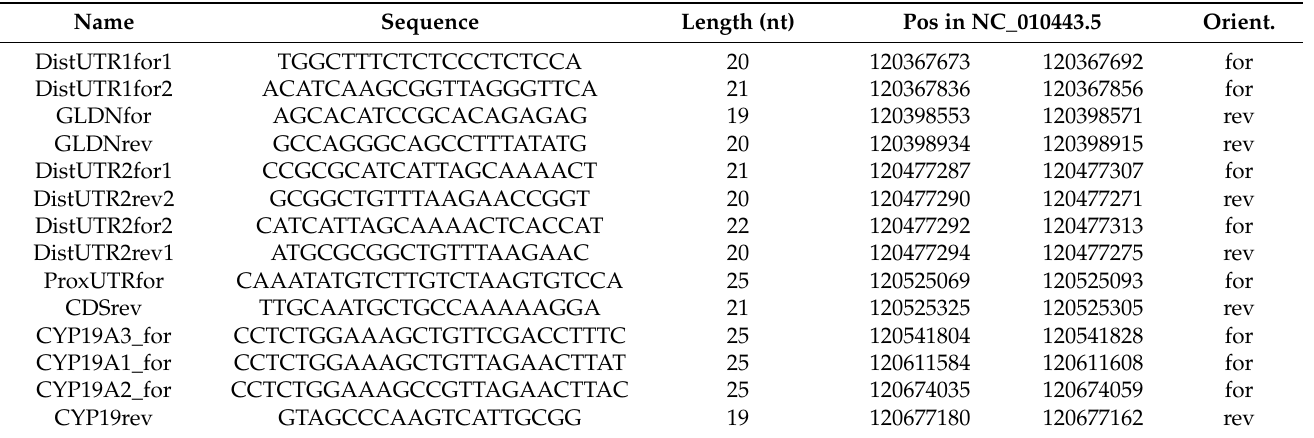
Table 3. Primers used for